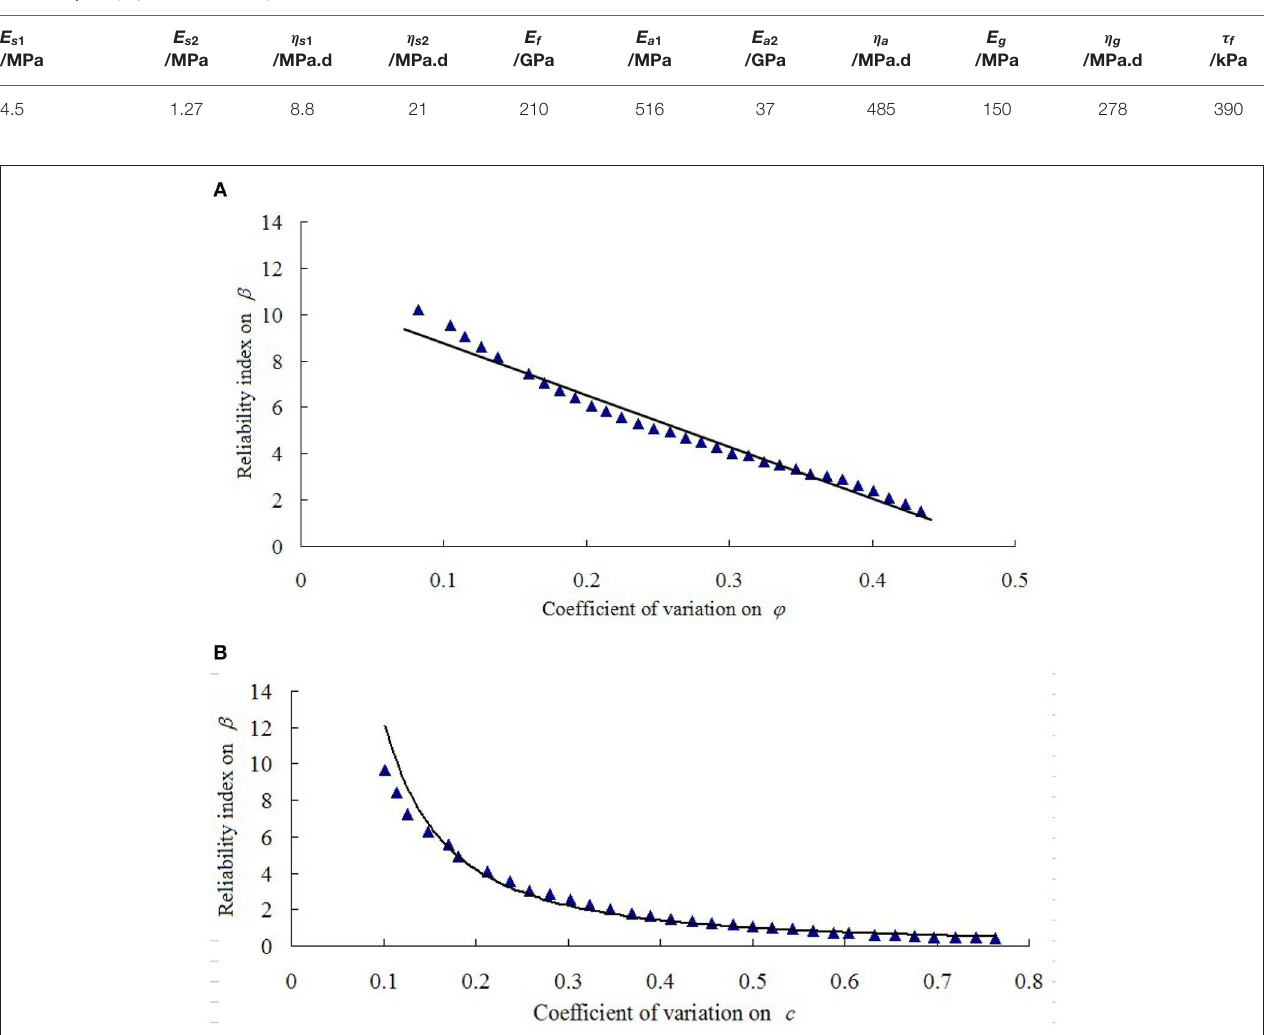
Frontiers in Earth Science |